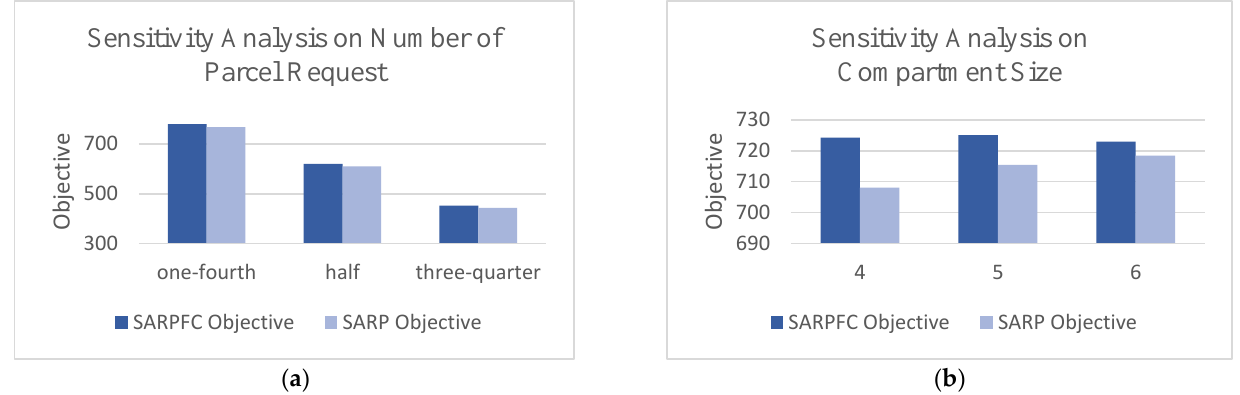
Figure 7. Sensitivity analysis: ( a ) impact of the number of parcel request on solution quality and ( b ) impact of compartment size on solution quality.